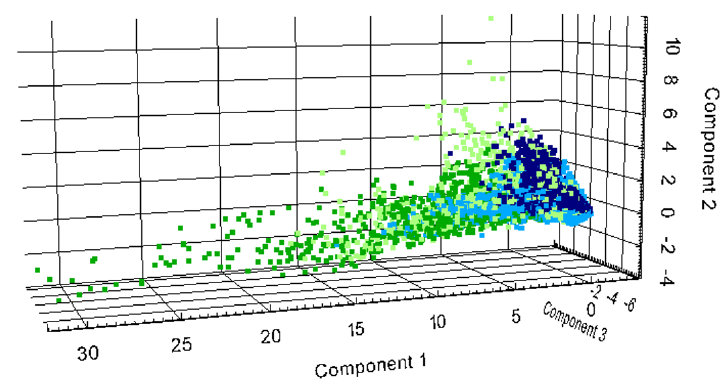
Figure 5. Discriminatory peptide signatures within groups of patients with clinical symptoms of myocarditis. 2D scores plot of MALDI IMS-derived spectra for components 1, 2, and 3 shows possibility of distinguishing endomyocardial biopsy peptide signature of patients with human herpesvirus 6 (HHV6) and myocarditis (dark-green cluster), myocarditis without HHV6 (dark blue), HHV6 without myocarditis (light-green cluster), and myocarditis-negative without HHV6 (pale-blue cluster).